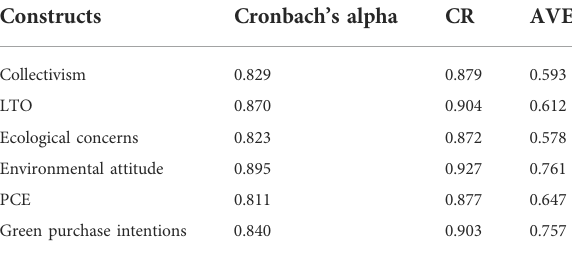
TABLE 3 Items, Cronbach ’ s alpha, standard loading, composite reliability (CR), and average variance extracted